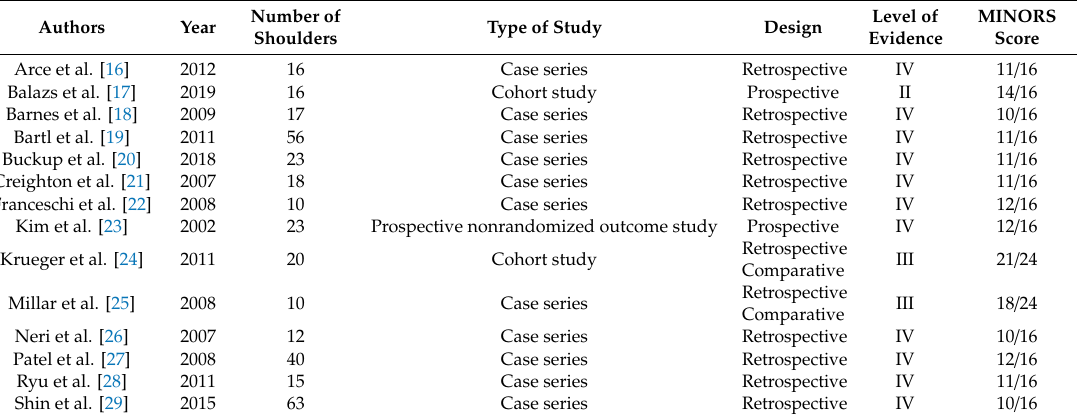
Table 1. Study characteristics of included studies.